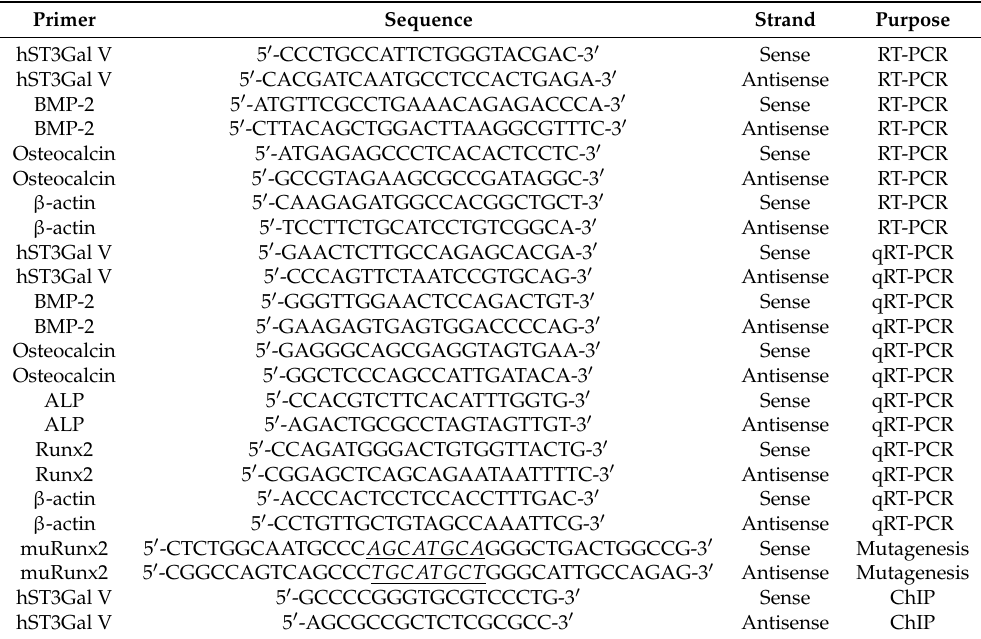
Table 1. Primer sequences used for reverse transcription-polymerase chain reaction (RT-PCR) and quantitative real-time PCR (qPCR), site-directed mutagenesis and chromatin immunoprecipitation (ChIP). Primer